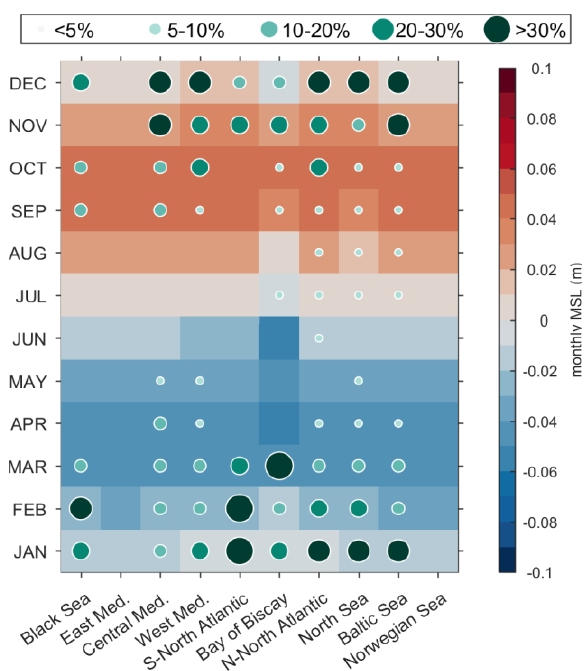
Figure 9. AMMSL along the coastline (closest 1° × 1° tile) averaged by oceanographic regions and monthly frequency of storm impact registered on each region (larger dot size indicate higher frequency). Table 2. Rank correlation coefficient between the annual cycle ofregionally averaged AMMSL and relative monthly frequency of storm event in the database.